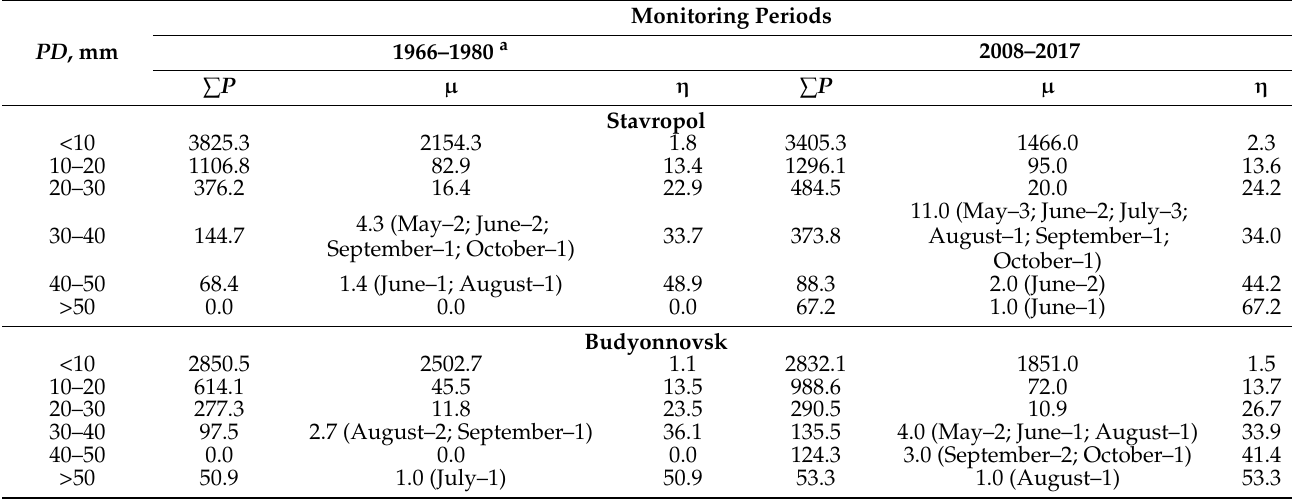
Table 4. Changes in precipitation depths ( PD ) at meteorological stations in Stavropol and Budyonnovsk (the Stavropol Krai, SW Russia; see Figure 1) between 1966–1980 and